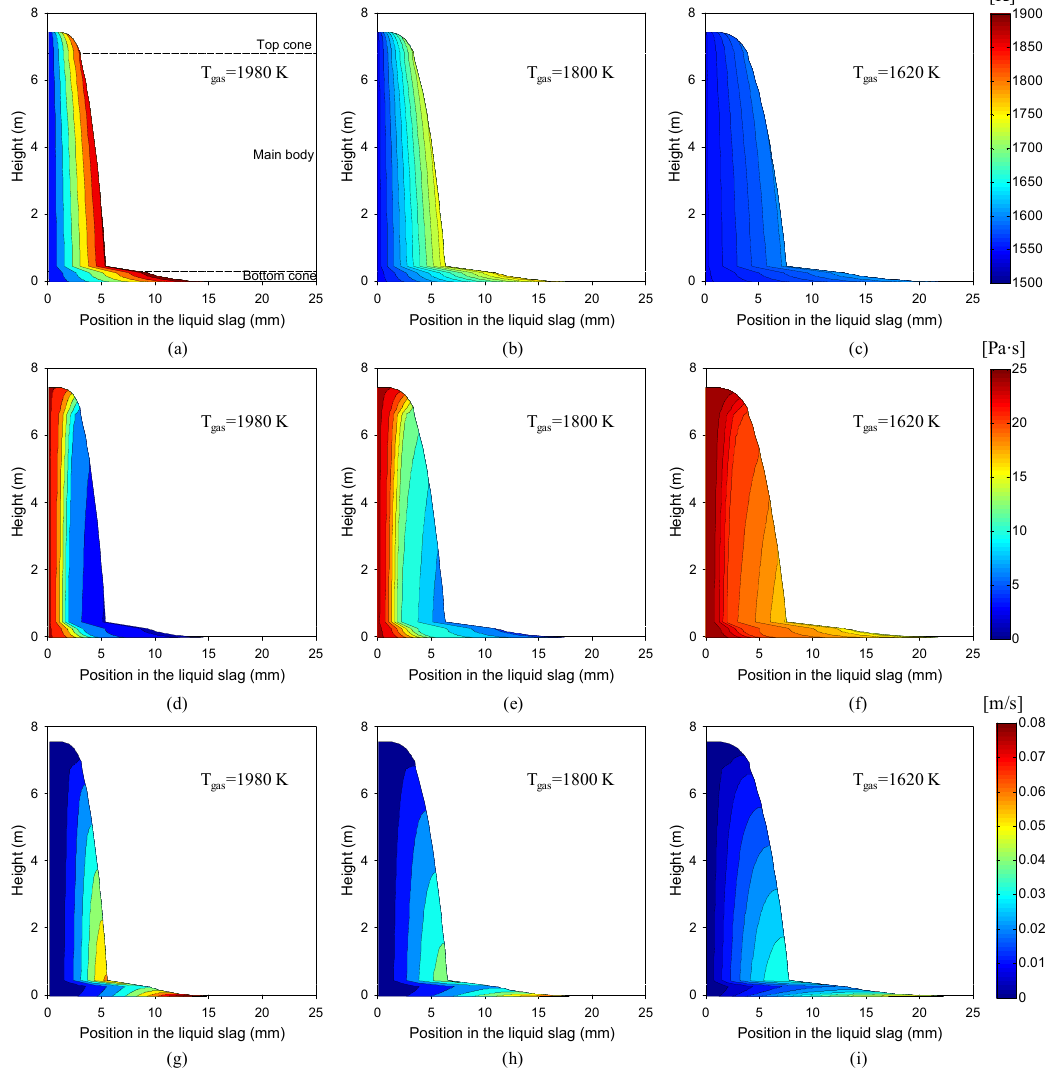
Figure 2. Slag temperature ( a – c ), viscosity ( d – f ) and velocity distribution ( g – i ) in the liquid slag layer for different gas temperature